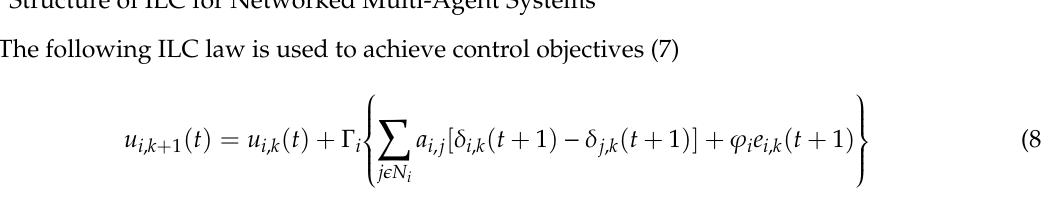
There exists information interaction if the agents are connected by dotted lines or solid lines.